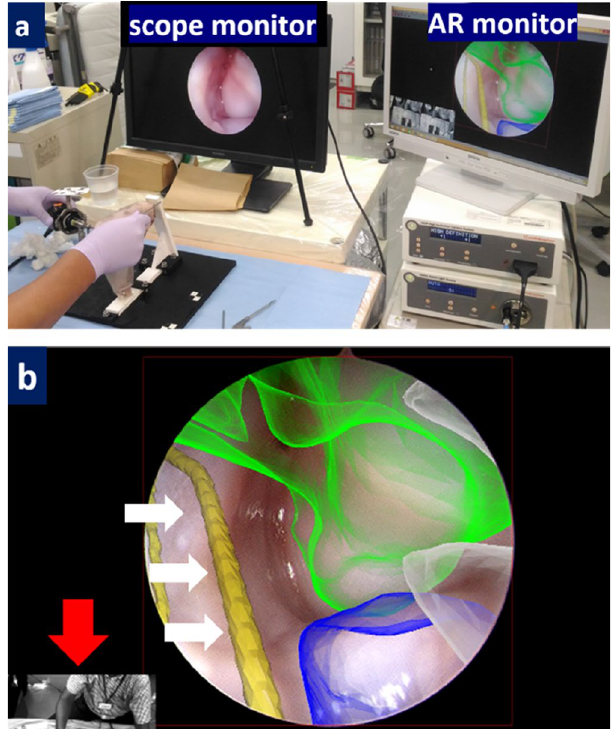
Figure 6. Augmented reality (AR) arthroscopy on cadaveric Japanese monkey elbow. Capitellum and radial head were visualized through the anteromedial portal and visualized on the scope monitor ( a ). The humeroradial joint and radial nerve (white arrows) were superimposed on the real view ( b ). The red arrow indicates a third person view using the stereo camera on the optical tracking device.